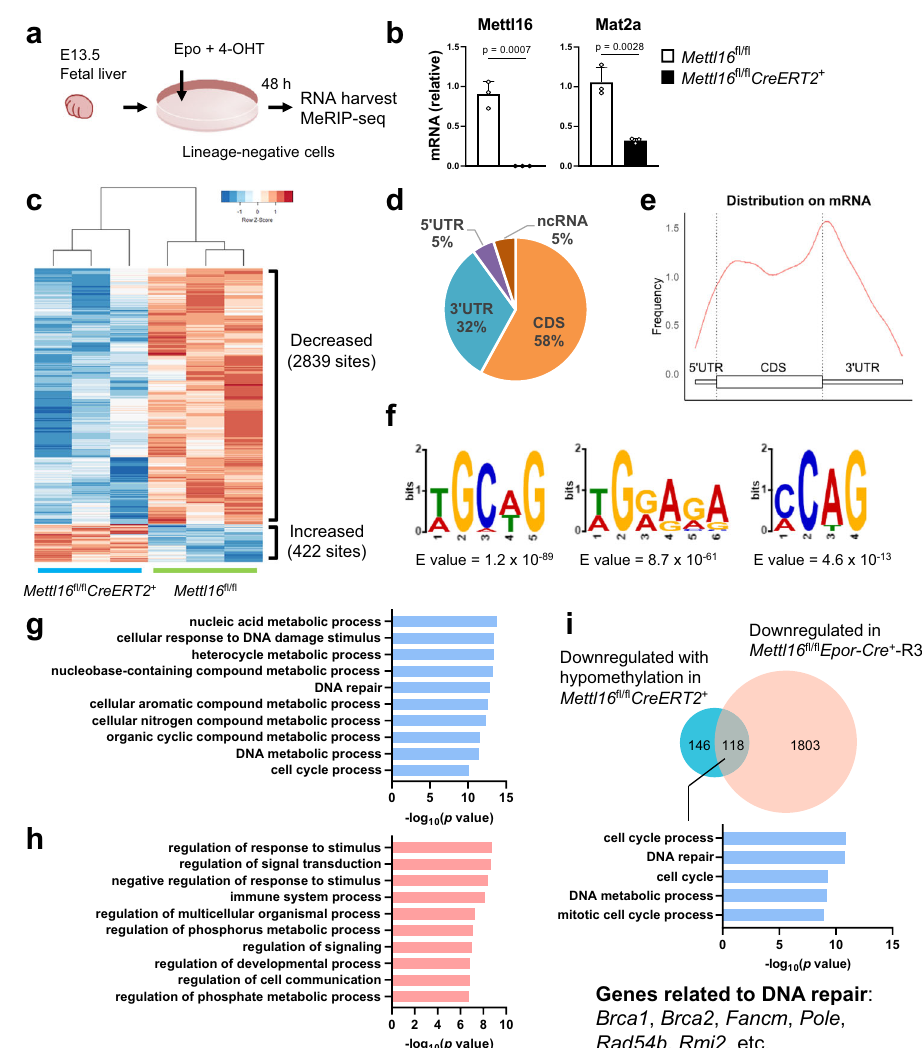
Fig.4|METTL16regulatesthedepositionofm 6 Amodi fi cationonDNA-damage response-associated mRNAs. a Outline of the in vitro erythroid culture experi- ments (Methods). b mRNA expression levels in cultured erythroblasts from E13.5 controland Mettl16 fl / fl CreERT2 + mice( n =3biologicalreplicates).Dataareexpressed as mean±SD. The p -values were calculated using two-tailed Student ’ s t -test. c – f MeRIP-seq analyses using poly(A) + RNAs incultured erythroblasts from control and Mettl16 fl / fl CreERT2 + mice. Signi fi cantly differentially methylated sites were identi fi ed using RADAR ( n =3 independent experiments). c Heatmap showing the relative methylation levels at these sites. d The fractions within the 5 ′ UTR, CDS, 3 ′ Source data are provided as a Source Data fi